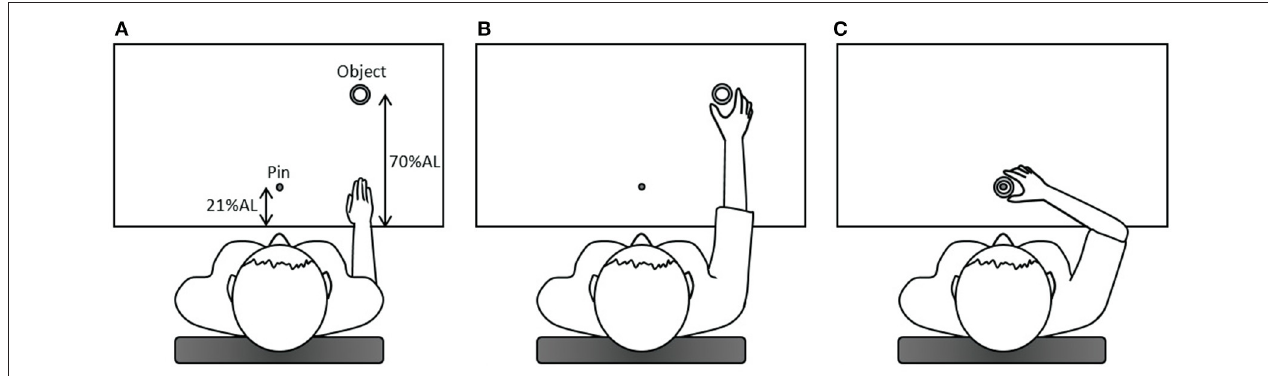
FIGURE 1 | The diagram of the right-hand task. (A) In the beginning, the right hand was placed at the starting position; (B) upon hearing the starting signal, the participant was required to use the thumb and index finger of the right hand to reach for and grasp the object (the reach-to-grasp movement); (C) subsequently, the participant placed the object to the pin, which was the end target. AL, arm